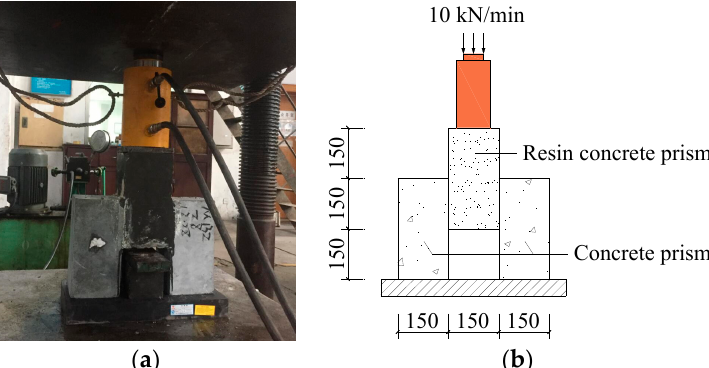
Figure 4. Bond strength test for the bond strength between the resin concrete and normal concrete: ( a ) Physical map, ( b ) sketch map (mm).